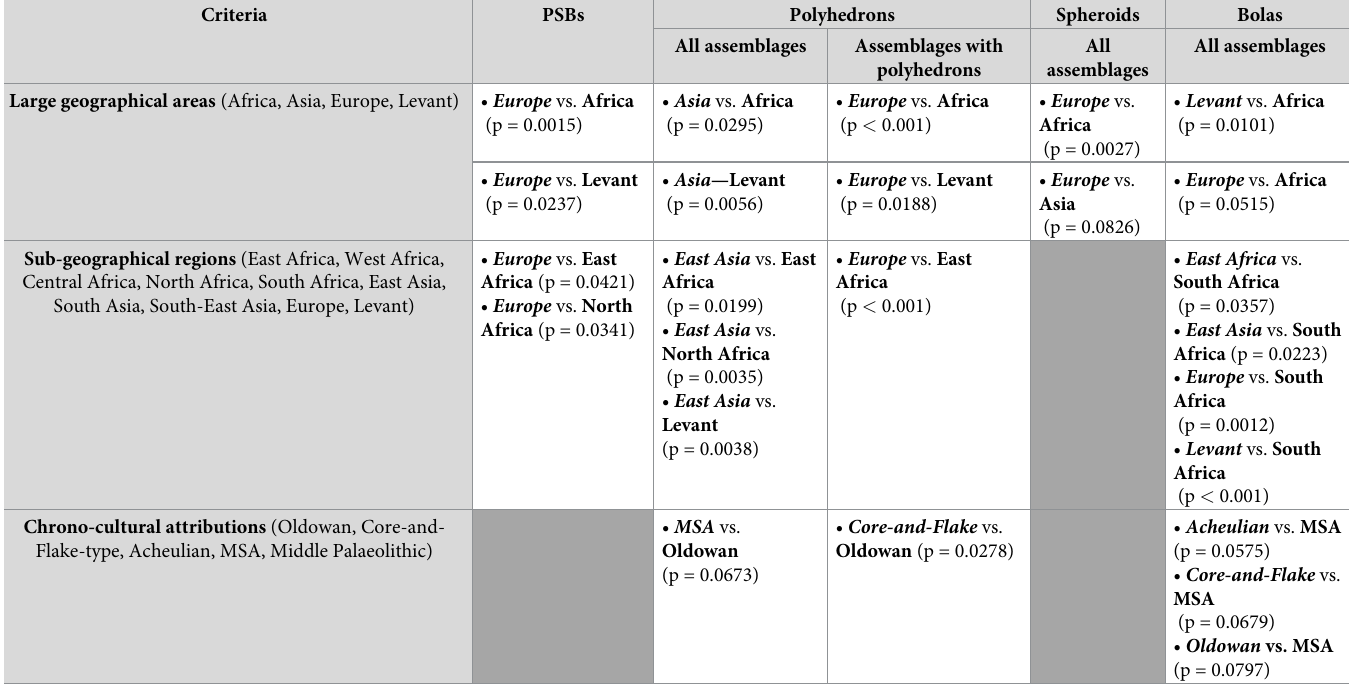
Table 1. Statistically significant differences in quantities of PSBs according to regions and chrono-cultural attribution. Criteria